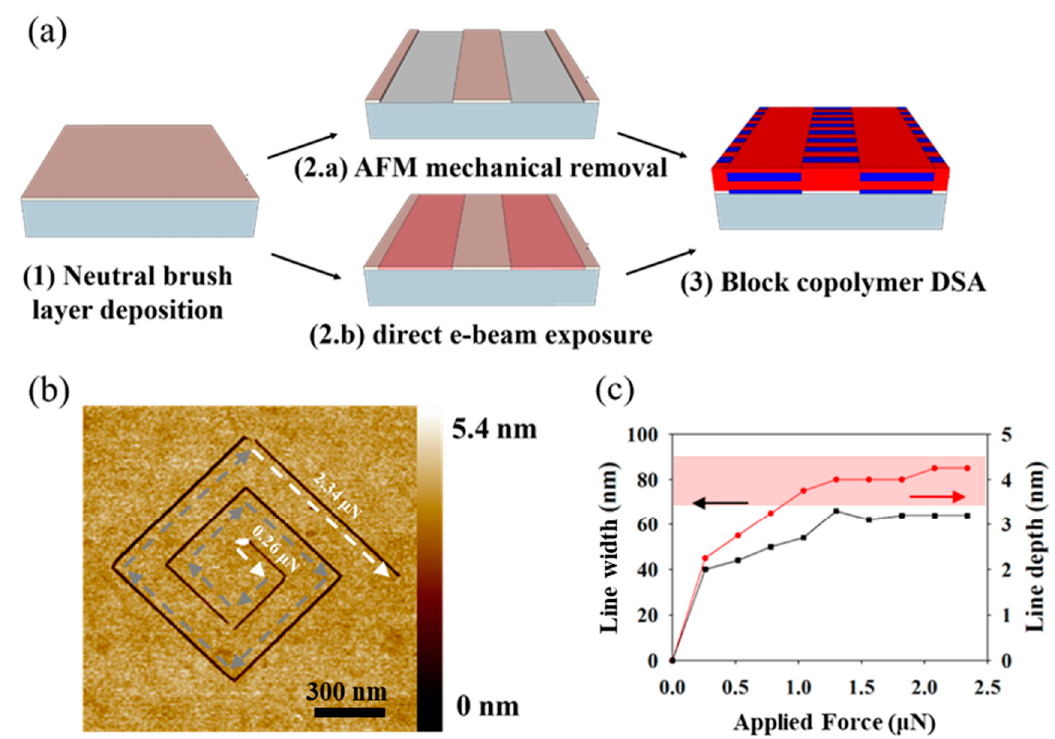
Figure 1. Grain boundary induced alignment principle and work-flow. ( a ) Work-flow to direct the self-assembly of block copolymers by grain-boundary-induced alignment; ( b ) Force-dependence of the mechanical brush removal while successively increasing the contact force from 0.26 µ N to 2.34 µ N from the inside to the outside of the spiral. ( c ) Linewidth (y-axis on left hand side) and line depth (y-axis on right hand side) as a function of the applied force extracted from the pattern shown in ( b ).